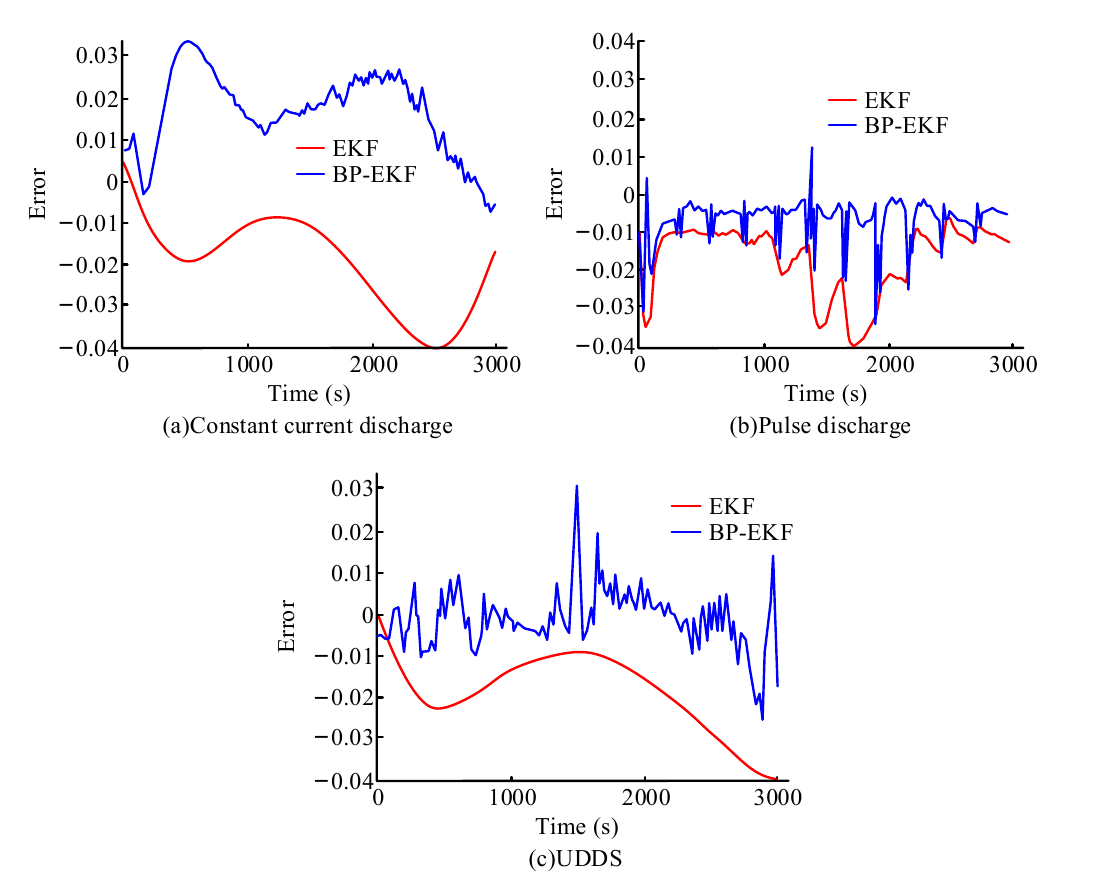
Figure 10. Model estimation effect under six initial SOC values (EKF and BP-EKF